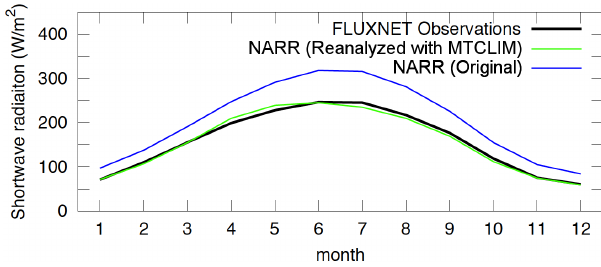
Figure 3. Comparison of shortwave radiation from original and re- analyzed NARR against observations averaged over 23 FLUXNET sites across North